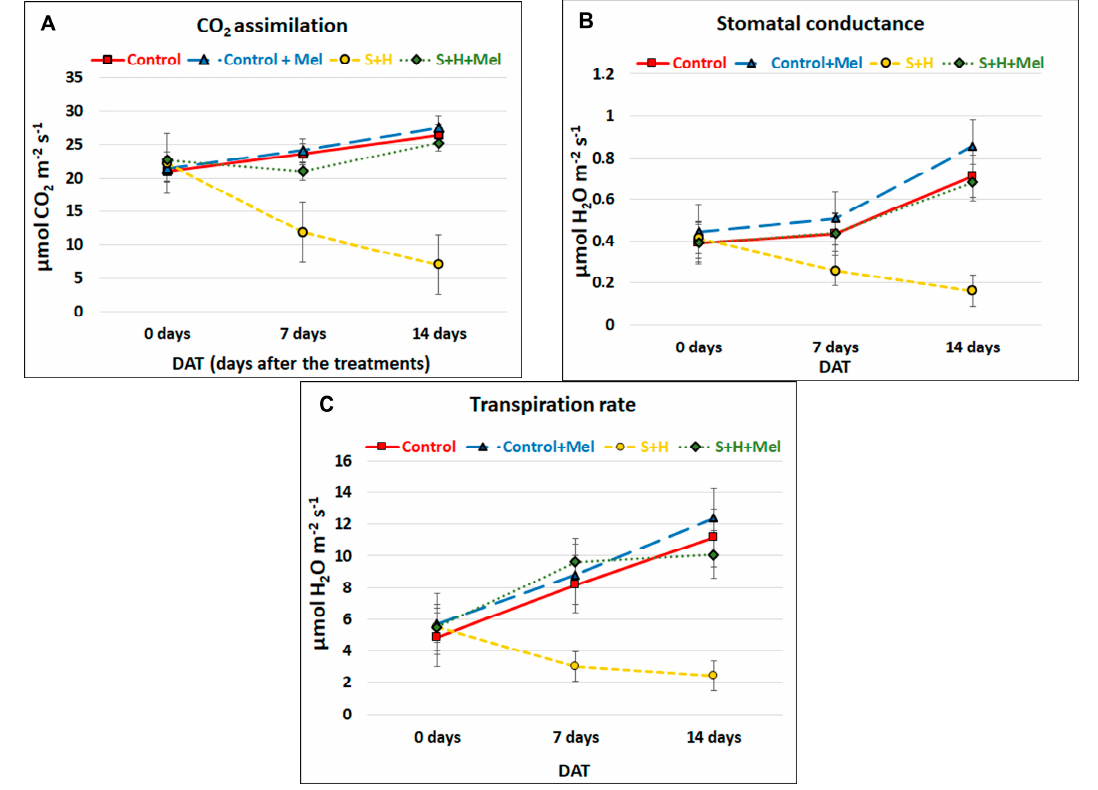
Figure 3. Photosynthetic-related parameters in leaves of tomato plants grown under control or stress combination conditions (salinity + heat, S + H) with (+MEL) or without melatonin pre-treatment. Values represent means ± SE ( n = 12) ( A ) CO 2 assimilation rate; ( B ) Stomatal conductance; ( C ) Transpiration rate. The figure is representative of four different measurements during the experiment. Values represent means ± SE ( n = 12).